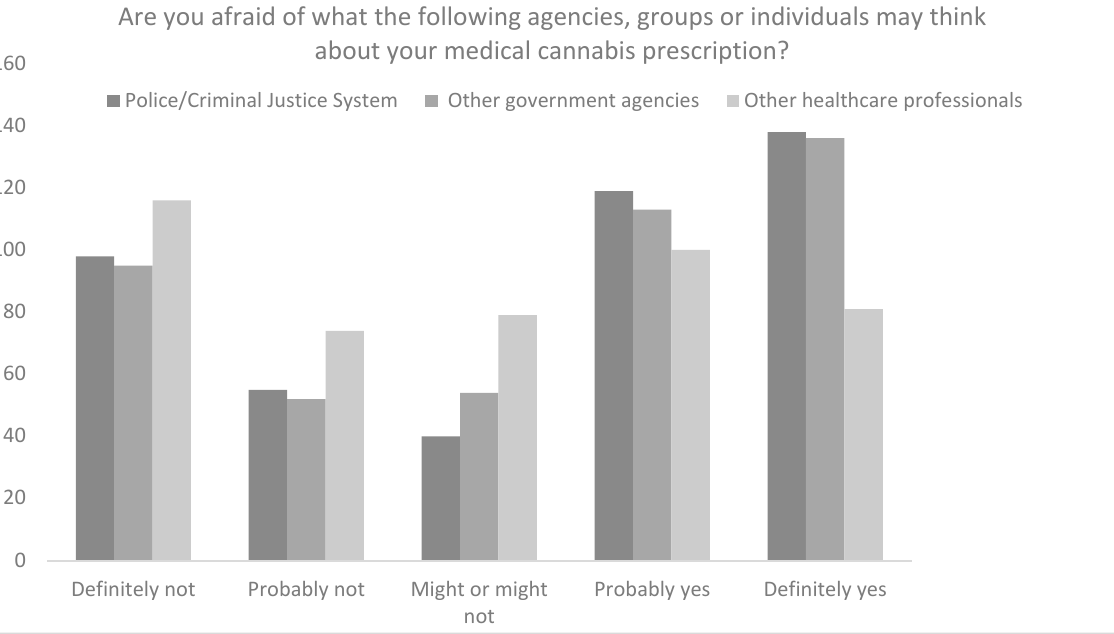
Figure 3. Raw responses to the question “Are you afraid of what the following agencies, groups or individuals may think about your medical cannabis prescription?”.